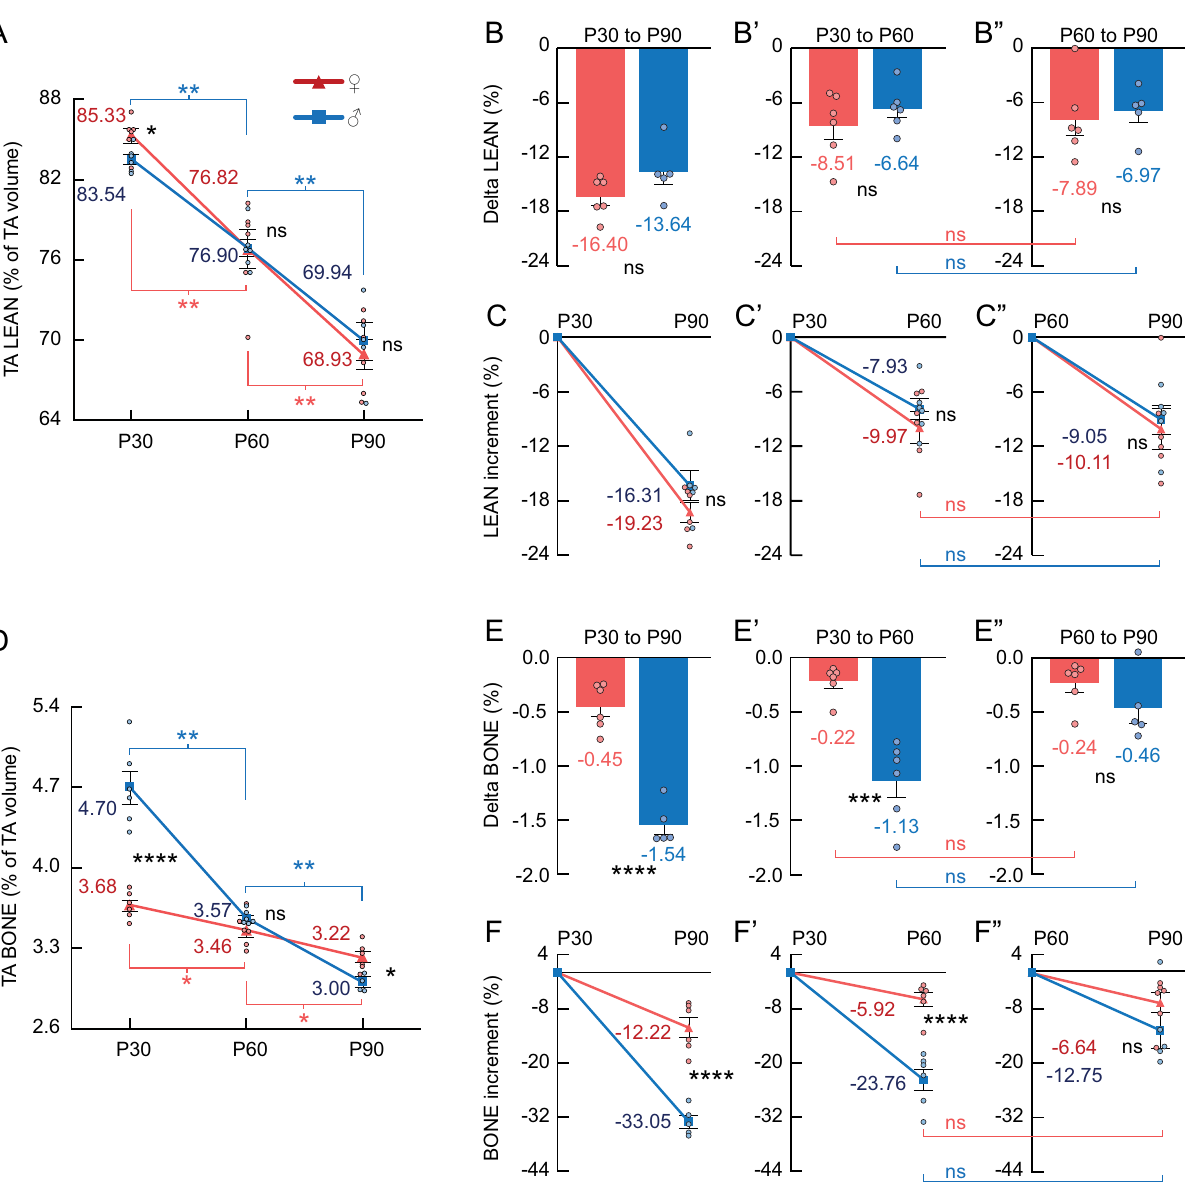
Figure 5. Female (red) and male (blue) comparisons of TA LEAN% and TA BONE%. ( A ) Relative lean contents (LEAN%). The split-plot ANOVA revealed a main effect of age in TA LEAN% (F 2,20 = 142.98, p < .01). ( D ) Relative bone contents (BONE%). The split-plot ANOVA revealed an interaction between age and sex in BONE% (F 2,14 = 40.45, p < .01), with main effects of age (F 2,20 = 117.51, p < .01) and sex (F 1,10 = 24.35, p < .01). ( B–B” and E-E” ) Delta LEAN% and delta BONE% (respectively). ( C–C” and F-F” ) LEAN% and BONE% (respectively) percentual increment (%). Statistics : Between-subjects effects were followed with Fisher’s LSD post-hoc. Paired T-test was used for within-subjects comparisons. Unpaired T-test was used in delta and increment between-subjects comparisons. Black stars (*): female versus male. Blue symbols: within-male comparisons. Red symbols: within-female comparisons. Values represented as mean and SEM. Significance levels: * p < .05, ** p < .01, *** p < .001, **** p < .0001, ns: p >